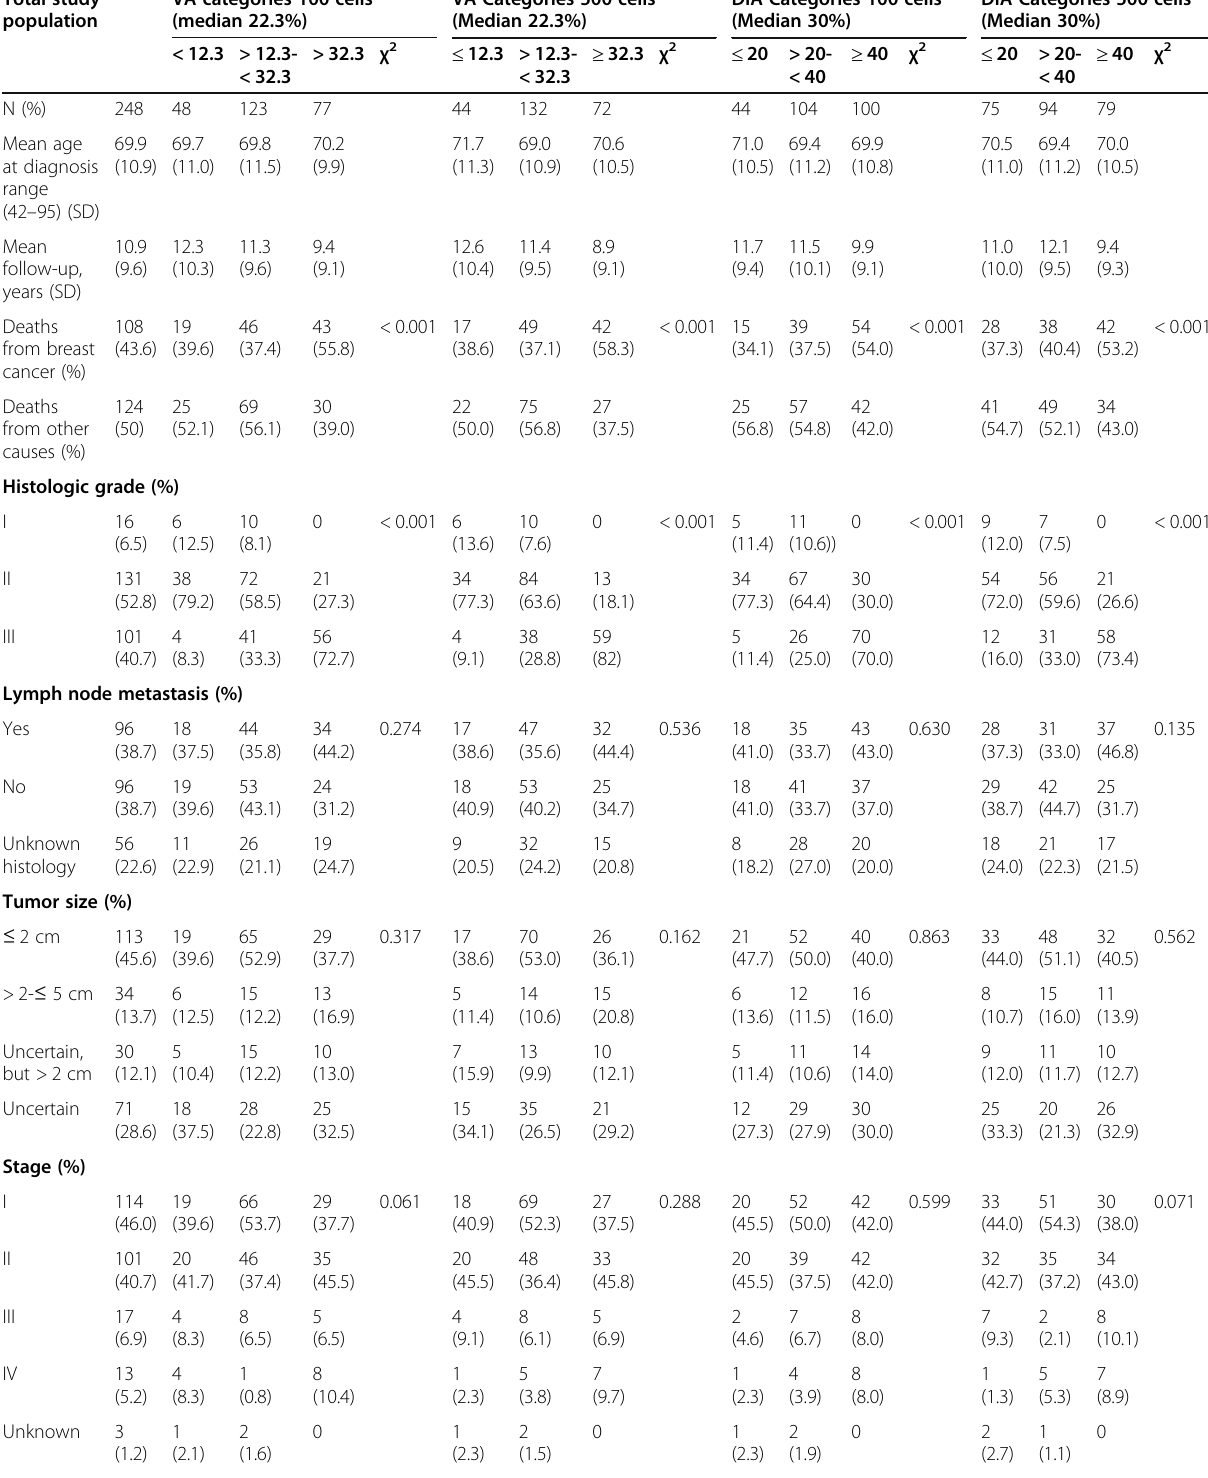
Table 1 Patient and tumour characteristics according to Ki67 visual assessment (VA) and digital image analysis (DIA) of full face tissue